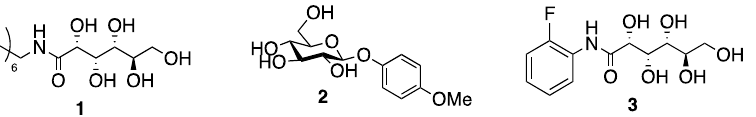
Figure 1. Structures of small molecule ice recrystallization inhibitors synthesized in the Ben laboratory.